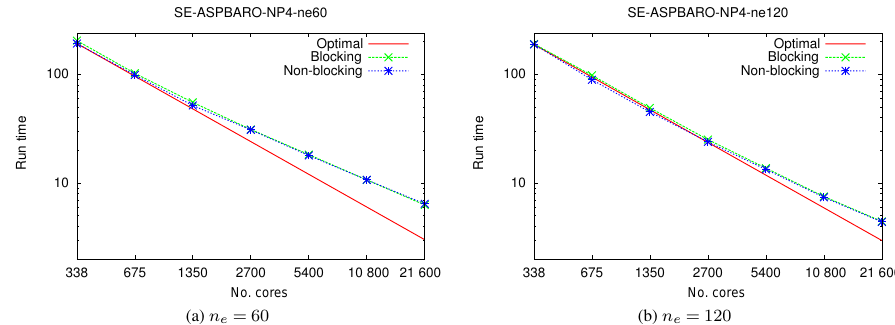
Figure 5. Strong scaling of the SE method in HOMME the Jablonowski–Williamson test baroclinic wave instability test case for n e = 60 (a) and n e = 120 (b) . For these runs we used np = 4 and nlev = 26. For n e = 60 we computed 4860 time steps, and for n e = 120 we computed 1080 time steps.